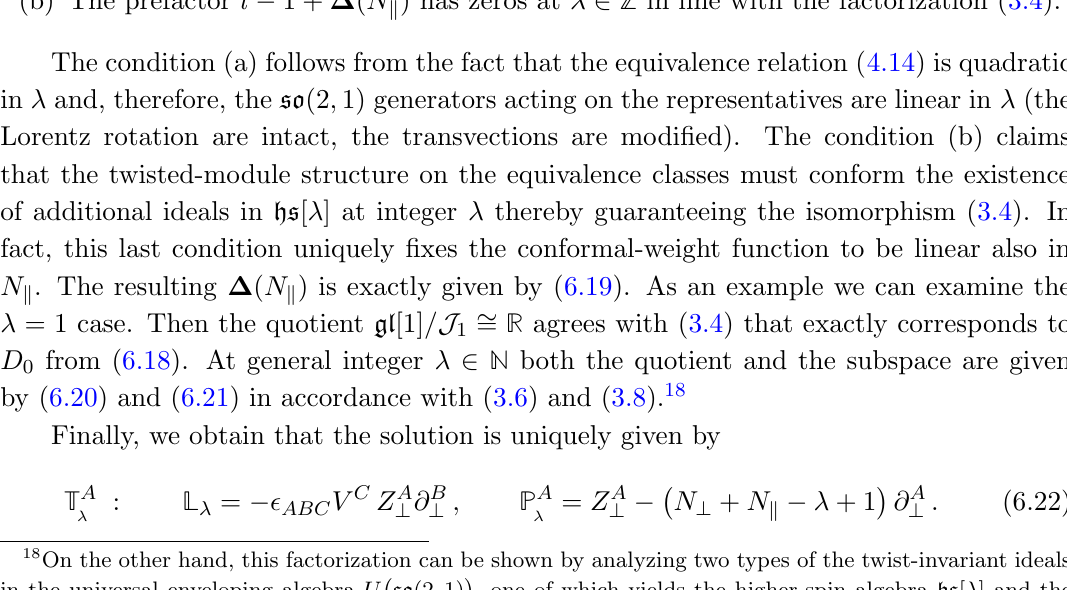
Figure 3 . The subspace singled out by the modi(cid:12)ed trace condition is sliced into Verma H (cid:1) modules with n = 0 ; 1 ; 2 ; : : : , see (6.6). Green and red contours show V (cid:1) n respectively. The vertical violet line visualizes the factorization for the conformal-weight func- tion